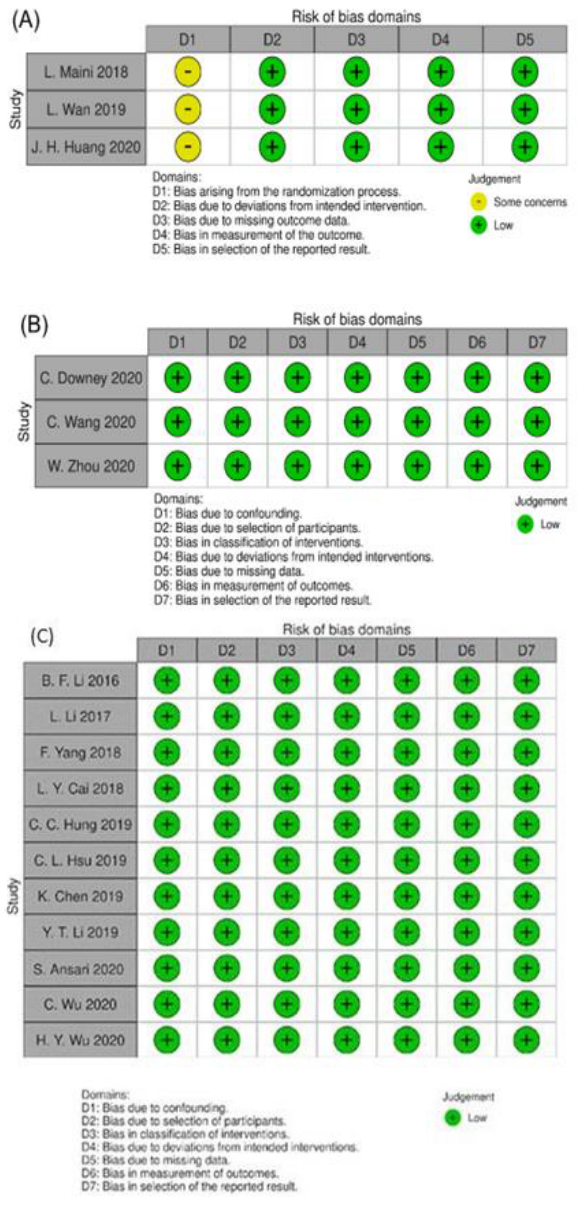
Figure 2. Risk of bias assessed with ( A ) revised Cochrane risk-of-bias tool for randomized controlled trials (RoB 2); ( B ) risk of bias in non-randomized studies-of interventions (ROBINS-I) assessment tool for non-randomized trials; and ( C ) risk of bias in non-randomized studies-of interventions (ROBINS-I) assessment tool for retrospective studies.